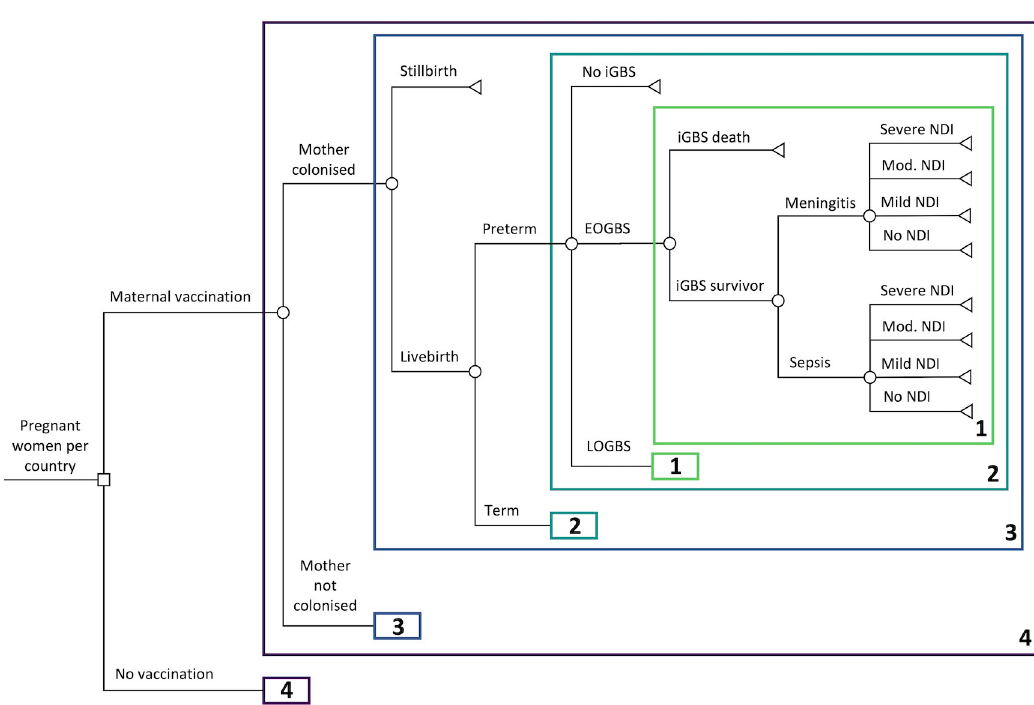
Fig 1. Decision tree for GBS-related outcomes in children for an annual birth cohort in 183 countries comparing maternal vaccination against no vaccination (current standard of care). Numbered boxes represent repeated model structure; however, the risks for some outcomes vary across repeated branches. EOGBS, early-onset GBS; GBS, Group B Streptococcus; iGBS, invasive GBS; LOGBS, late-onset GBS; NDI, neurodevelopmental